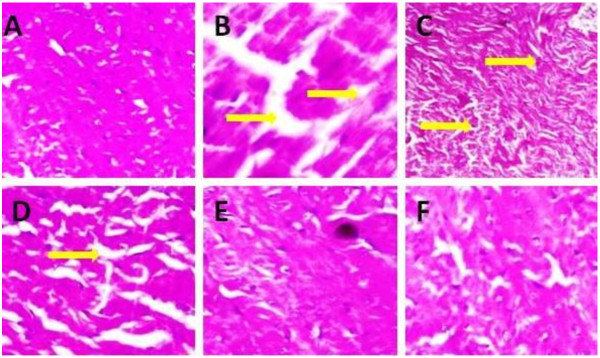
Effect of Umbelliferone β-D-galactopyranoside (UFG) photomicrographs of histological on heart in different groups of rats: (A) Normal control: Histopathology of normal control group rat normal histopathology of heart (B) Diabetic control: Histopathology of diabetic control group rat shown increased interstitial space and distort the intercalated disc (yellow arrow) (C) UFG I (10 mg/kg): Histopathology of tested drug shown decreased interstitial space and intercalated disc (yellow arrow) (D) UFG II (20 mg/kg): Histopathology of tested drug shown less interstitial space (yellow arrow) (E) UFG III (40 mg/kg): Histopathology of tested drug shown normal heart like the glibenclamide (F) Glibenclamide (10 mg/kg): Histopathology of glibenclamide treated drug shown the normal histopathology of heart. The samples were obtained from the same liver anatomical regions. For each group, 6 rats were examined and 80 pictures were taken. The above picture for each group was chosen randomly from the 80 pictures in this group. Original magnification, 40 × .